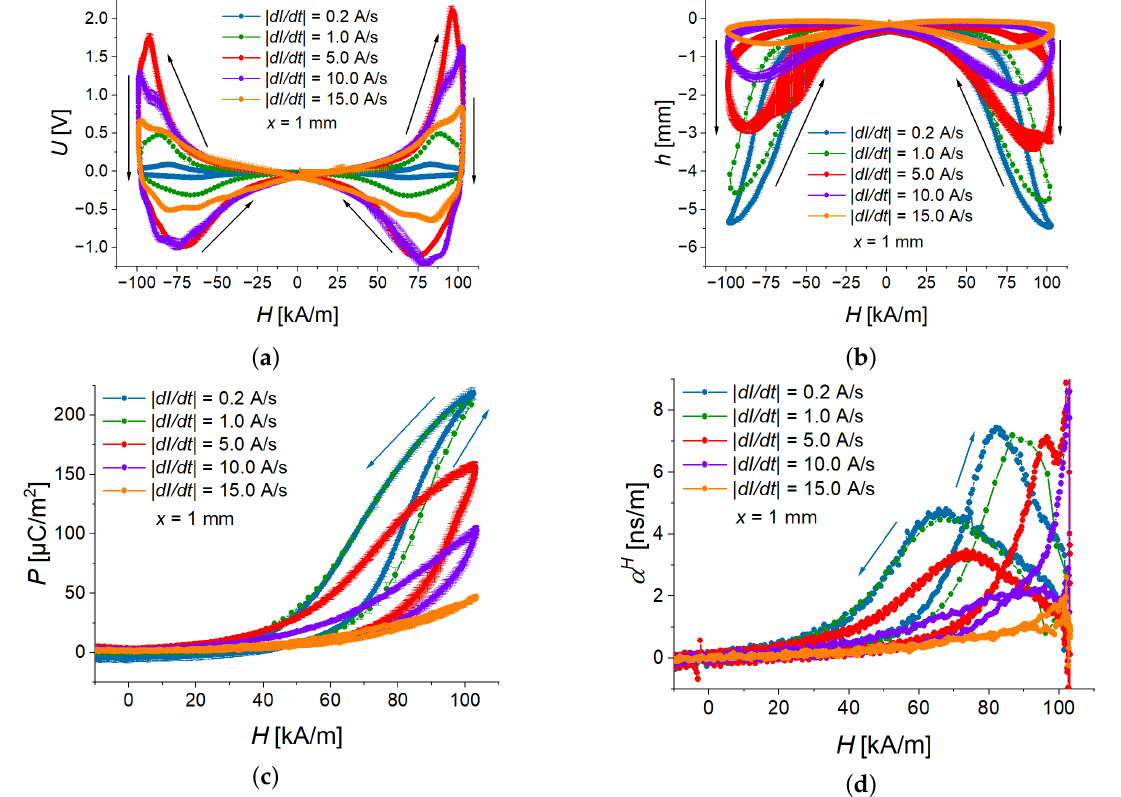
Figure 5. Average field dependences of generated voltage ( a ), deflection ( b ), polarization ( c ), and ME coupling coefficient ( d ) for different slew rates.